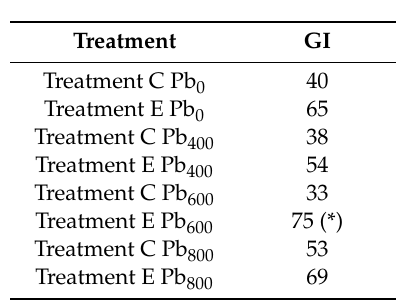
Table 2. Summary of germination index (GI) results. Number of germinated seeds of Festuca arundinacea with endophyte treatment ( E ) are compared with the control treatment ( C ) at increasing concentrations of lead in the soil. Significant statistical di ff erence ( p < 0.05) between endophytic and control set is marked with a (*).